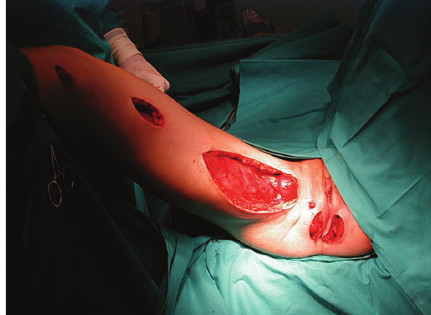
Figure 1: Graciloplasty procedure, wound configuration after gra- cilis muscle